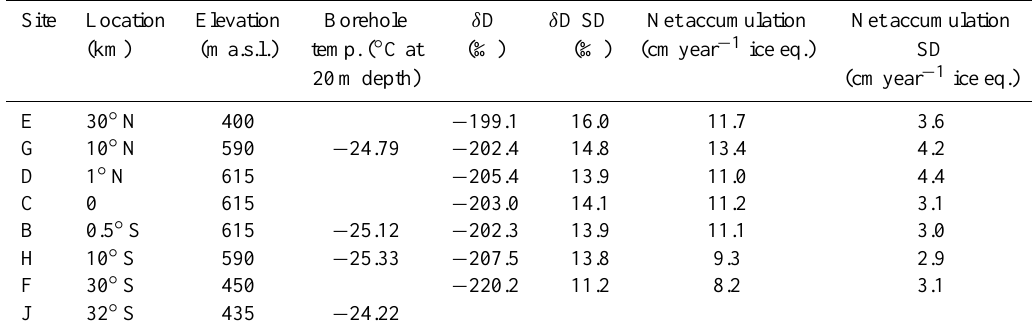
Table 2. Siple Dome shallow ice core data summary. The δ D, δ D standard deviation, net accumulation, and net accumulation standard deviation (SD) values pertain to the time period